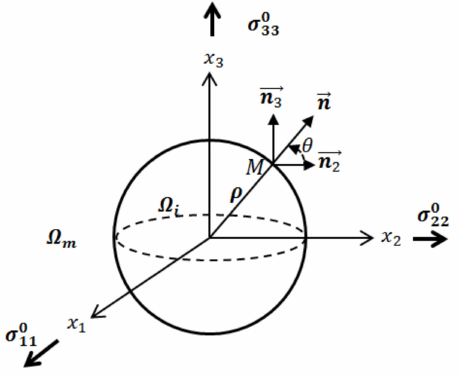
Figure 3. Vector position of point M in plane x 1 = 0 ( n 1 =